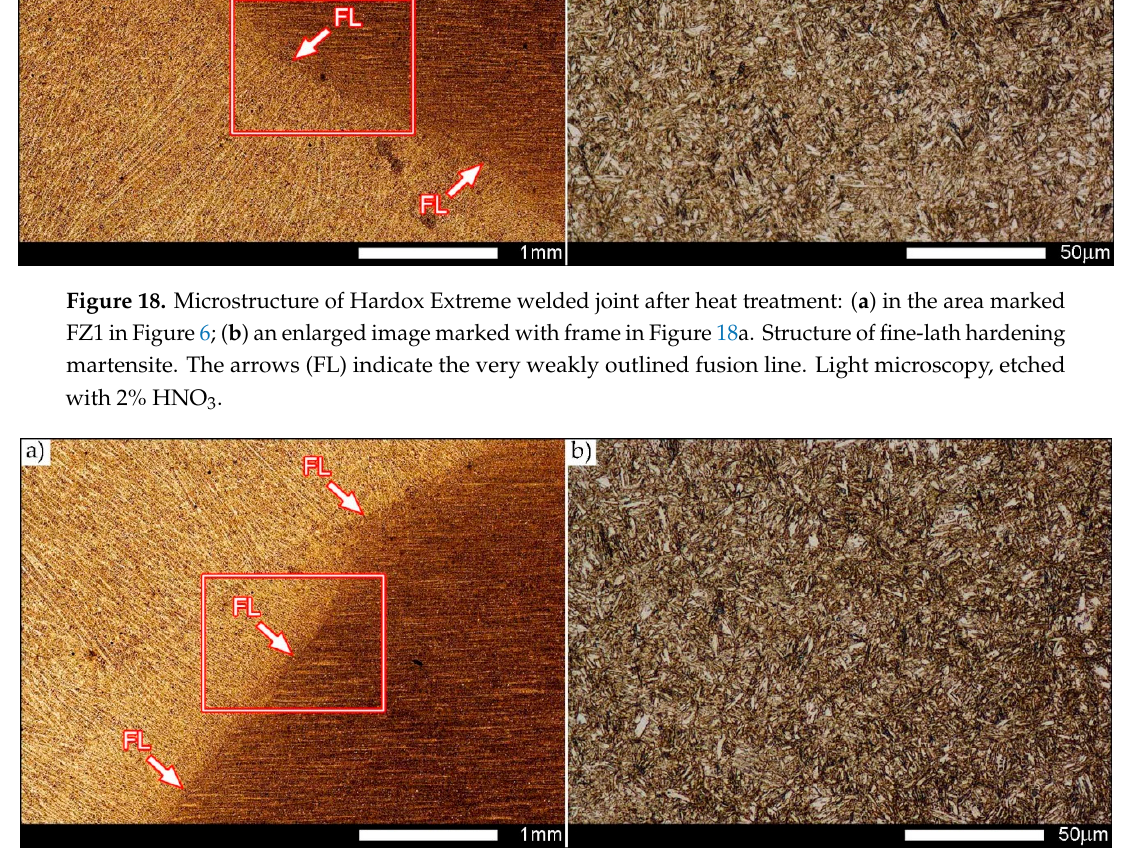
Figure 19. Microstructure of Hardox Extreme welded joint after heat treatment: ( a ) in the area marked FZ2 in Figure 6; ( b ) an enlarged image marked with frame in Figure 19a. Structure of fine-lath hardening martensite. The arrows (FL) indicate the very weakly outlined fusion line. Light microscopy, etched with 2% HNO 3 .